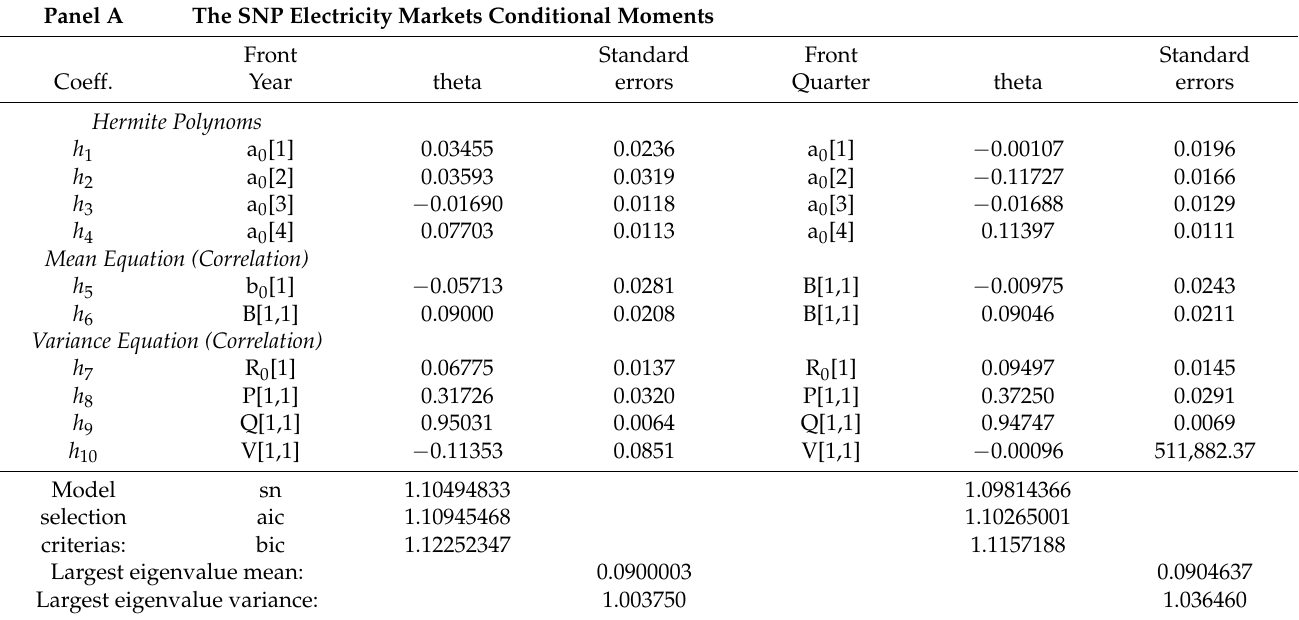
Table 2. Nasdaq OMX Moments and Stochastic Volatility Coefficients,